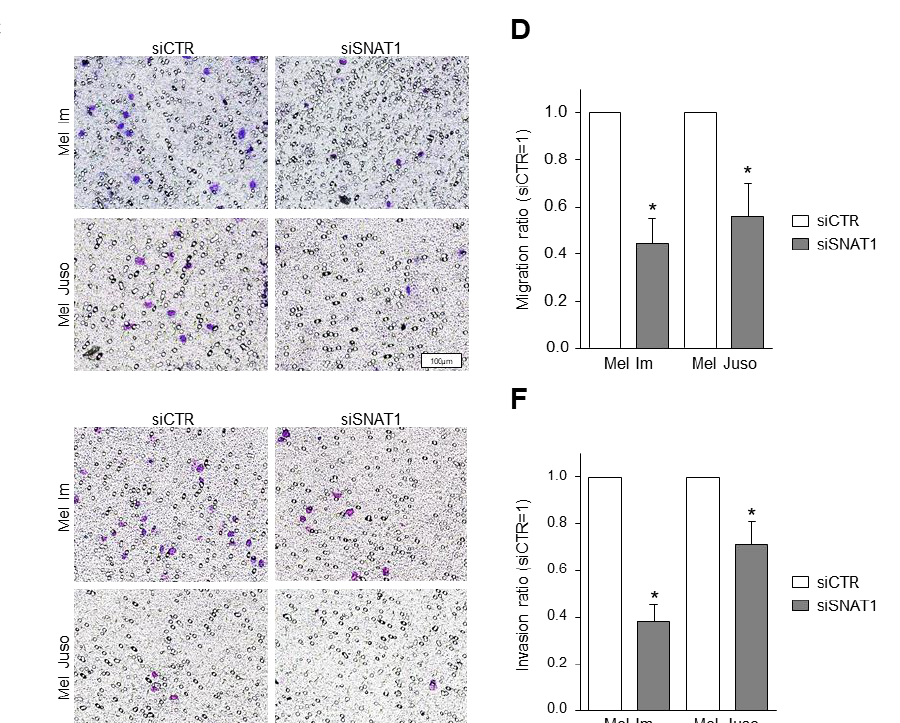
Figure 4. Effects of SNAT1 downregulation on migratory and invasive potential of melanoma cells. ( A , B ) Analysis of cell migration using scratch wound healing assay of Mel Im and Mel Juso cell lines after siSNAT1 downregulation when compared to siCTR cells. ( A ) Representative images of cell monolayer scratch of Mel Im cells 24 h and of Mel Juso cells 48 h after scratching. ( B ) Scratch width of Mel Im cells 24 h and of Mel Juso cells 48 h after scratching (siCTR = 1). Values represent the mean ± SEM of 4 independent experiments. ( C , D ) Analysis of cellular migration using Boyden chamber assay of Mel Im and Mel Juso cell lines after siRNA-mediated SNAT1 downregulation, compared to siCTR-transfected melanoma cells. ( C ) Representative images of Boyden chamber gelatine-coated filter membrane. ( D ) Quantification of migrated cells (siCTR = 1). Values represent the mean ± SEM of 4 independent experiments. ( E , F ) Analysis of cellular invasion using Boyden chamber assay of Mel Im and Mel Juso cell lines after siRNA-mediated SNAT1 downregulation, compared to siCTR- transfected melanoma cells. ( E ) Representative images of Boyden chamber Matrigel-coated filter membrane. ( F ) Quantification of invasive cells (siCTR = 1). Values represent the mean ± SEM of 4 independent experiments. p -value < 0.05 was considered statistically significant